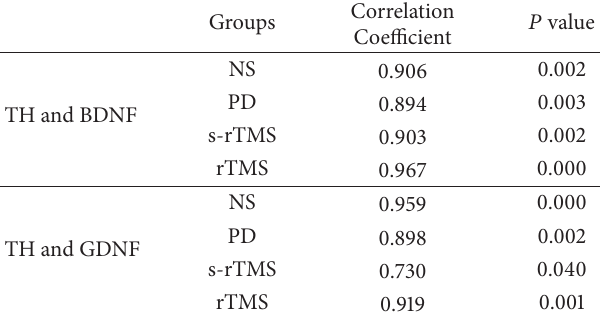
Table 1: Correlation analysis between COD values of TH and BDNF or GDNF as illustrated by immunohistochemical staining. in SN of